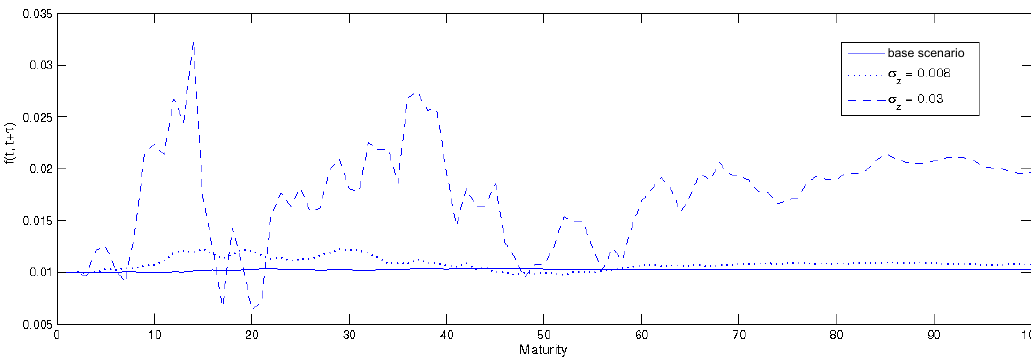
Figure 10. Forward instantaneous rate to varying ambiguity perceived by the economic individuals.